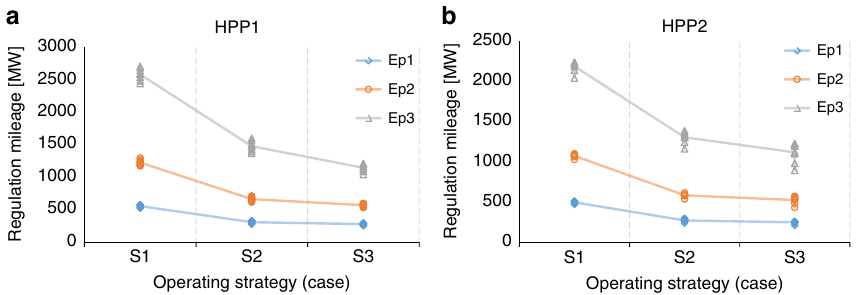
Fig. 4 Regulation mileage of two HPPs for 24 h. For each case, results from all seven operating points are close, hence the scatters overlap each other; the average values of seven points in various conditions are presented in Table 1. a For HPP 1; b For HPP